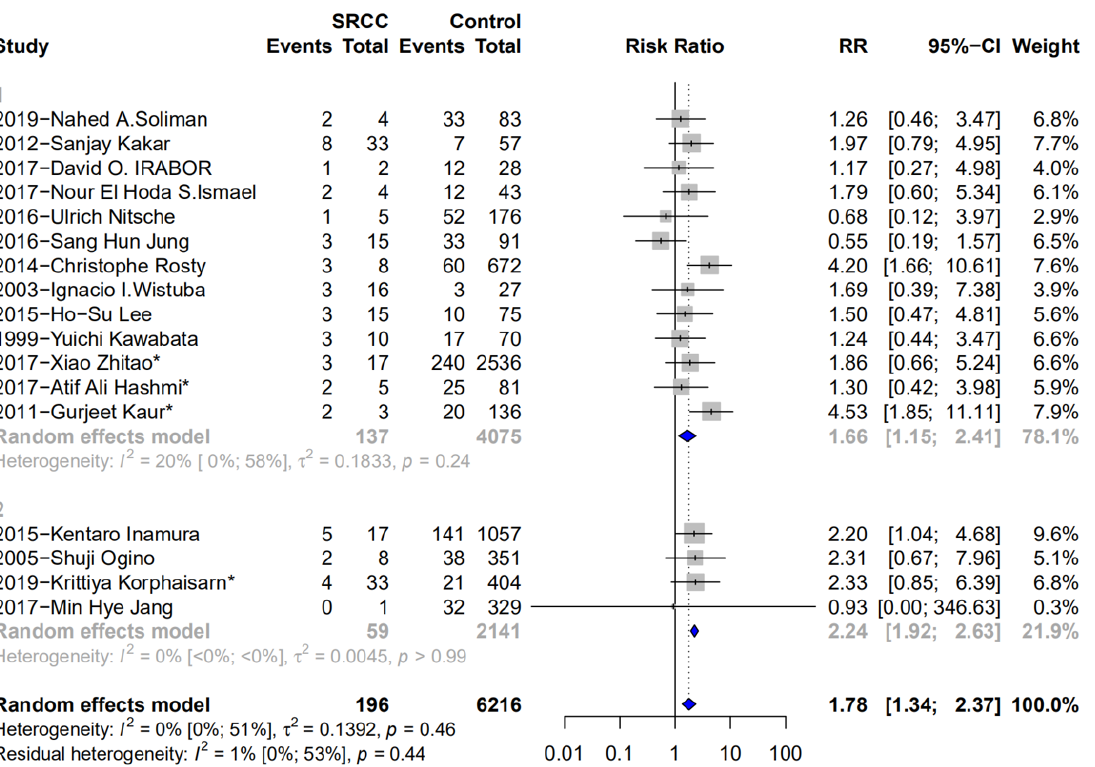
Figure 5. Forest plot for MSI-H status: ( 1 ) Forest plot for MSI-H status between SRCC and non-SRCC (SRC component < 50% was not excluded). ( 2 ) Forest plot for MSI-H status between SRCC and C-CRC (* represents these articles use MMR as test methods).